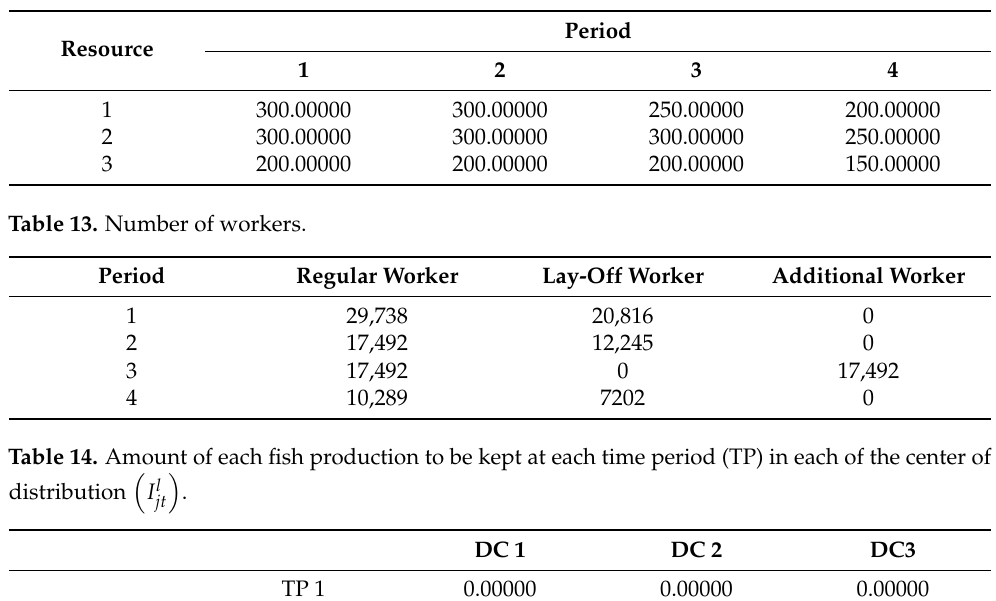
Table 12. Extra raw each resource to be bought for each period ( u it ) .